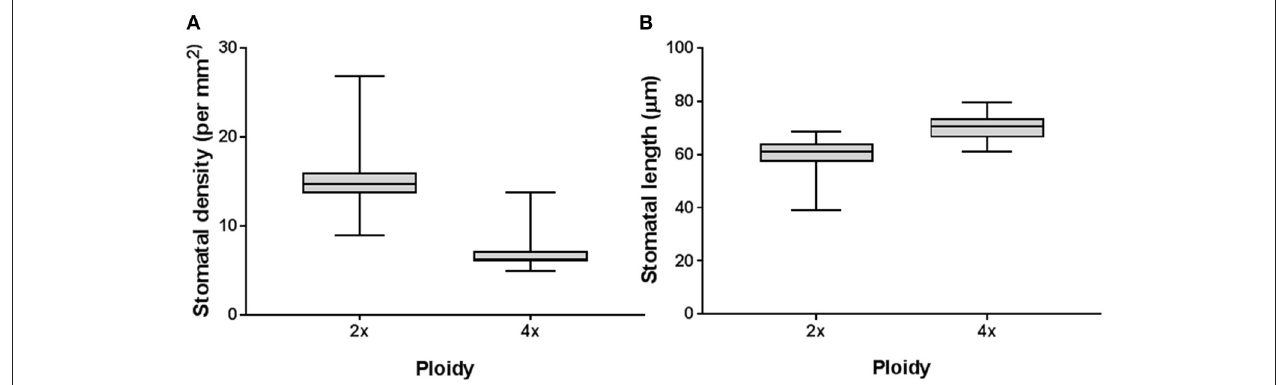
FIGURE 4 | Putative gamete-derived H. megalanthus lines. All the di-haploid lines were regarded as one group, and all the tetraploid lines, as another group. (A) Association between DNA ploidy and stomatal density ( P- value: < 0.0001, F -test P -value: 0.0036). (B) Association between DNA ploidy and stomatal length ( P -value: < 0.0001, F -test P -value: 0.3071). Data was analyzed using unpaired t -test with Welch’s